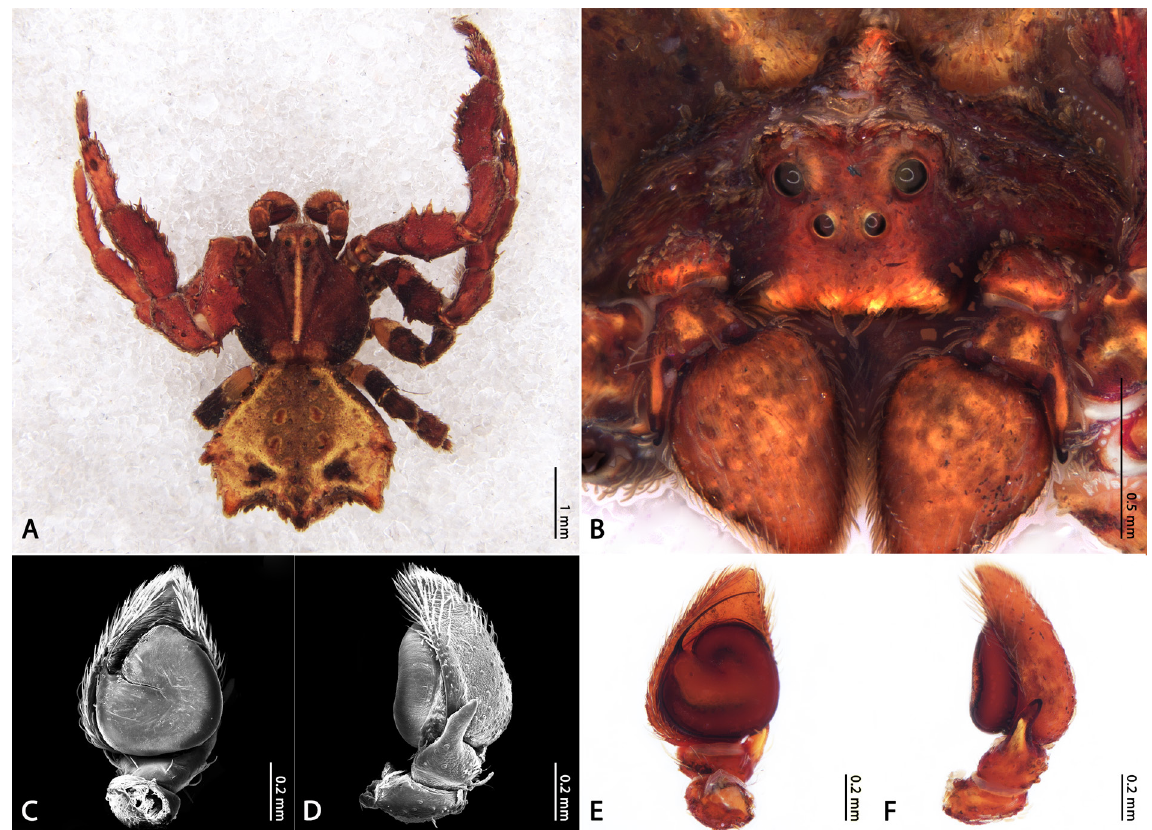
Fig. 6. Male of Kryptochroma macrostyla (Mello-Leitão, 1929) gen. et comb. nov. (MZSP 15320). A . Habitus, dorsal view. B . Front. C–F . Left male palp. C, E . Ventral view. D, F . Retrolateral